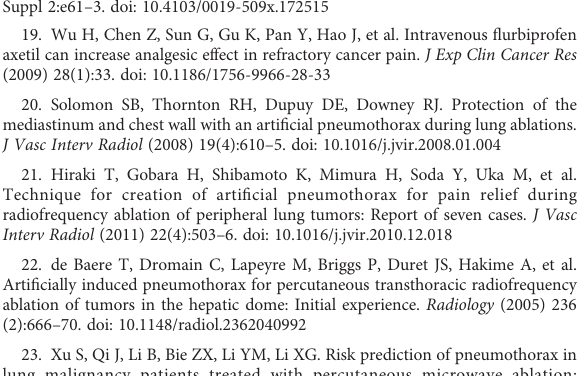
SUPPLEMENTARY FIGURE 1 Complications of MWA for subpleural pulmonary nodules. (A) After ablation of the tumor in the right lung, a CT scan revealed a large pneumothorax with decreased oxygen saturation in the patient. (B) The patient was placed on a chest tube for drainage. (C) A slight intraoperative intrathoracic bleeding was found in the patient ’ s right lower lobe lung lesion. (D) After treatment was completed, the scanafter antenna removal revealed an increase in pleural blood accumulation compared to the previous one, and symptomatic therapies such as hemostatic drugs were given, and the patient was closely monitored.